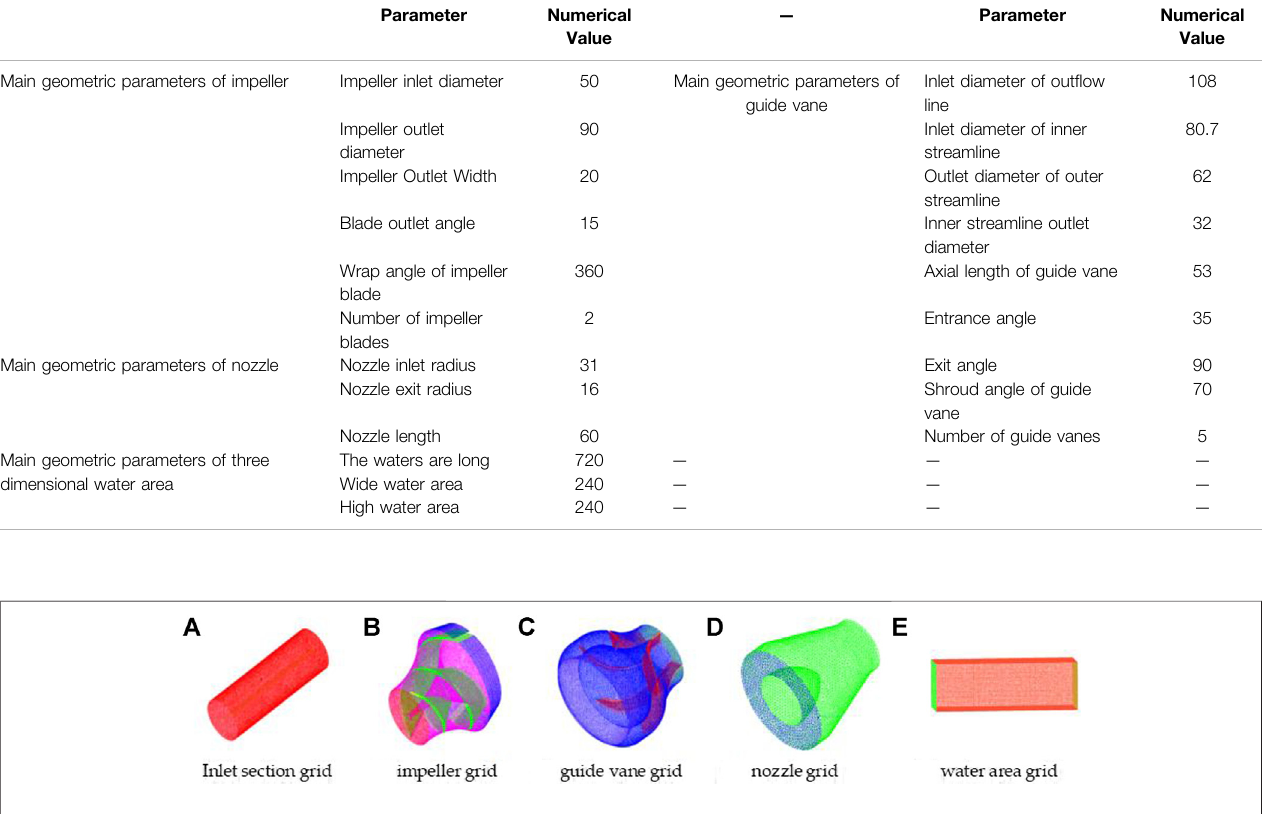
TABLE 1 | Geometric parameters of fl ow passage parts of water jet pump.